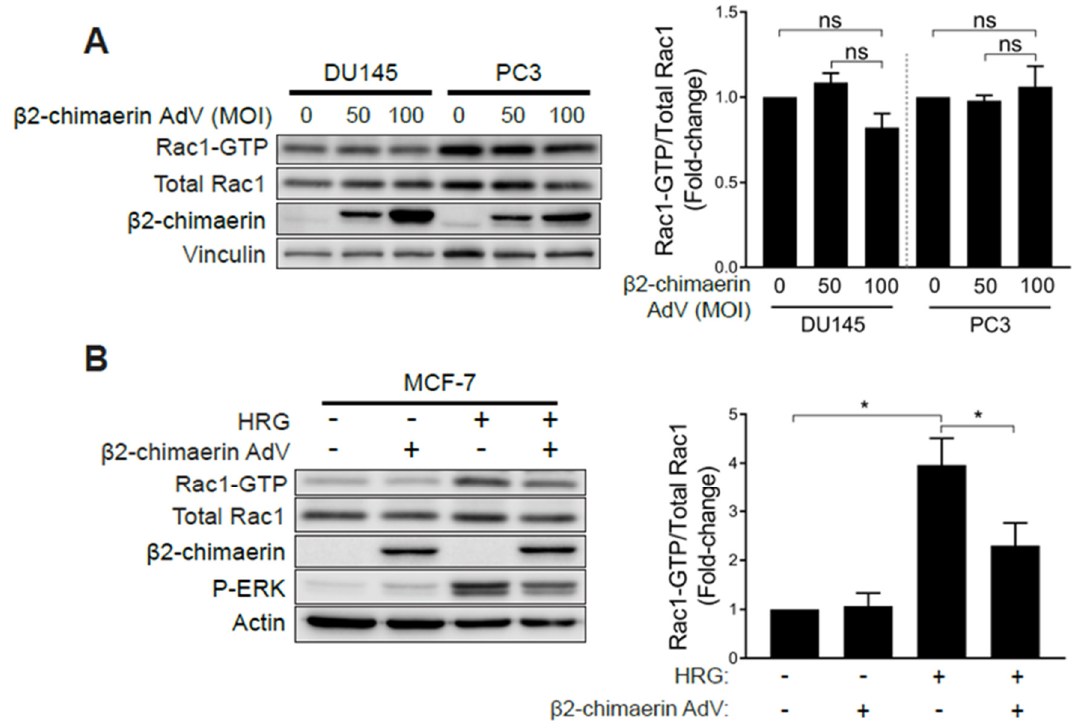
Figure 4. Elevated Rac1 activation in androgen-independent prostate cancer cells is insensitive to the Rac-GAP β 2-chimaerin. ( A ) DU145 and PC3 cells were infected with increasing MOIs (0–100 pfu / cell) of a β 2-chimaerin AdV. After 16 h, Rac1-GTP levels were determined using a PBD pull-down assay. ( B ) Similar experiments were carried out in MCF-7 cells stimulated with HRG (20 ng / mL, 5 min). Left panels , representative experiments. Right panels , densitometric analyses of Rac1-GTP / total Rac1. Results (normalized to MOI = 0 pfu / cell) are expressed as the mean ± S.E. ( n = 3–4). *, p < 0.05; n.s., not significant.